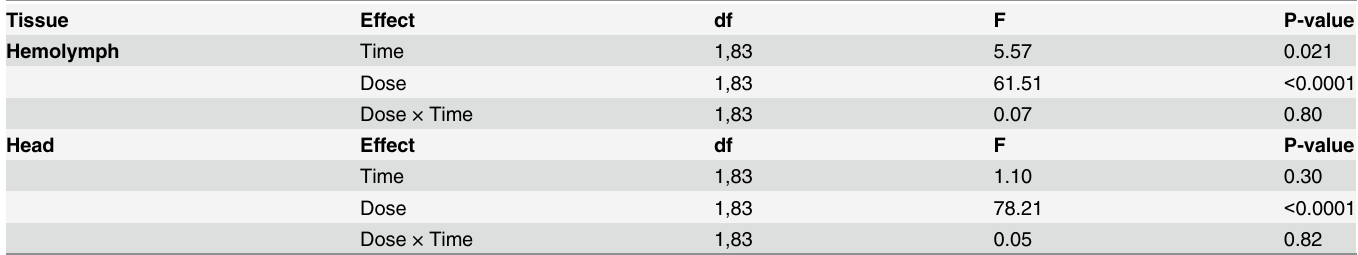
Table 2. Transporter function assays. Bees treated with a series of dosages of the MDR transporter-inhibitor verapamil before and after ingestion of the fluorescent substrate Rhodamine B solution, and assayed at two times (24 and 48 h post ingestion) show greater fluorescence at increased verapamil con- centrations in both tissues. Tissue